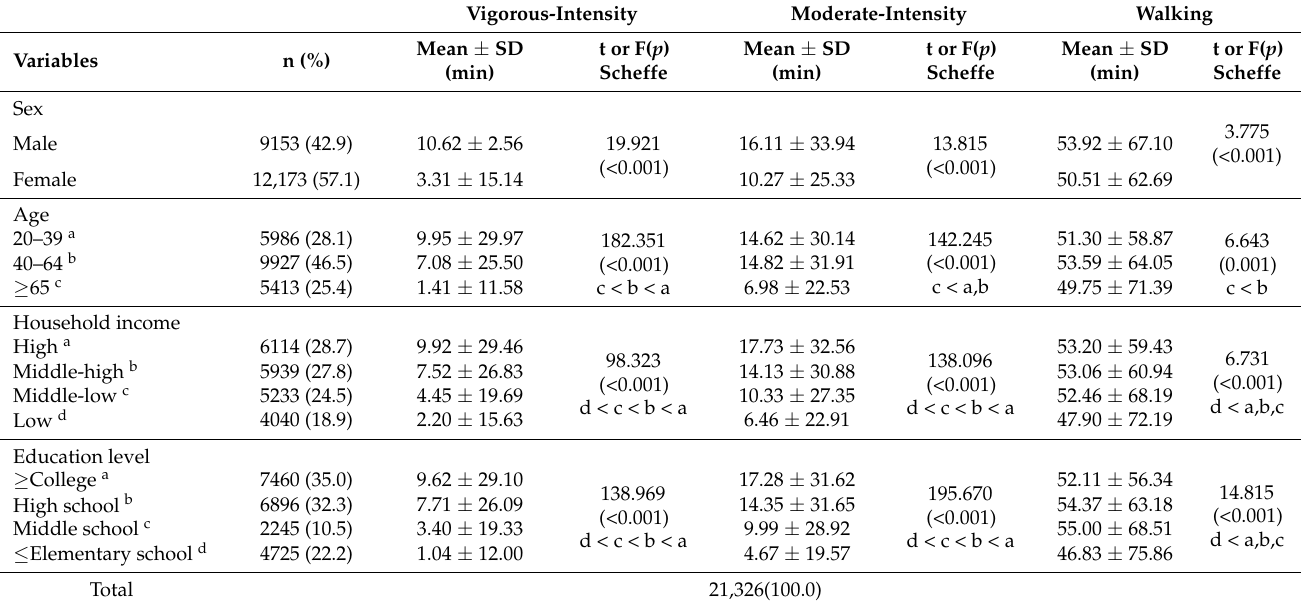
Table 1. General characteristics according to vigorous-intensity, moderate-intensity, and walking